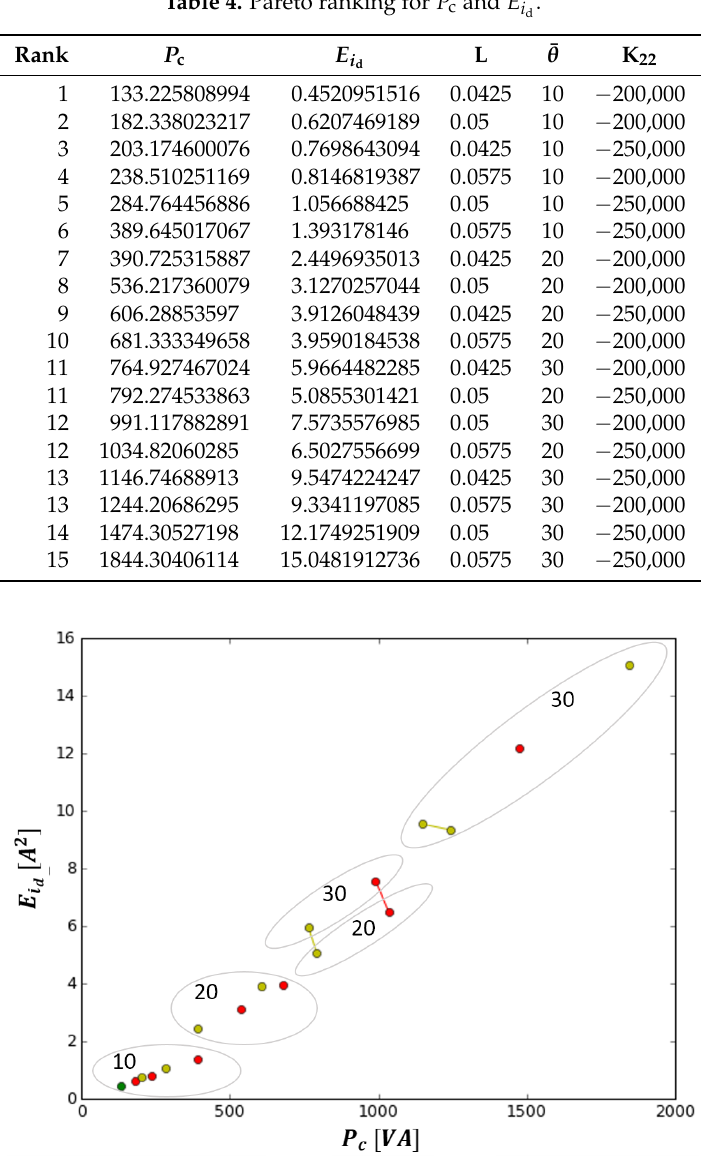
Figure 15. Pareto front for P c and E i